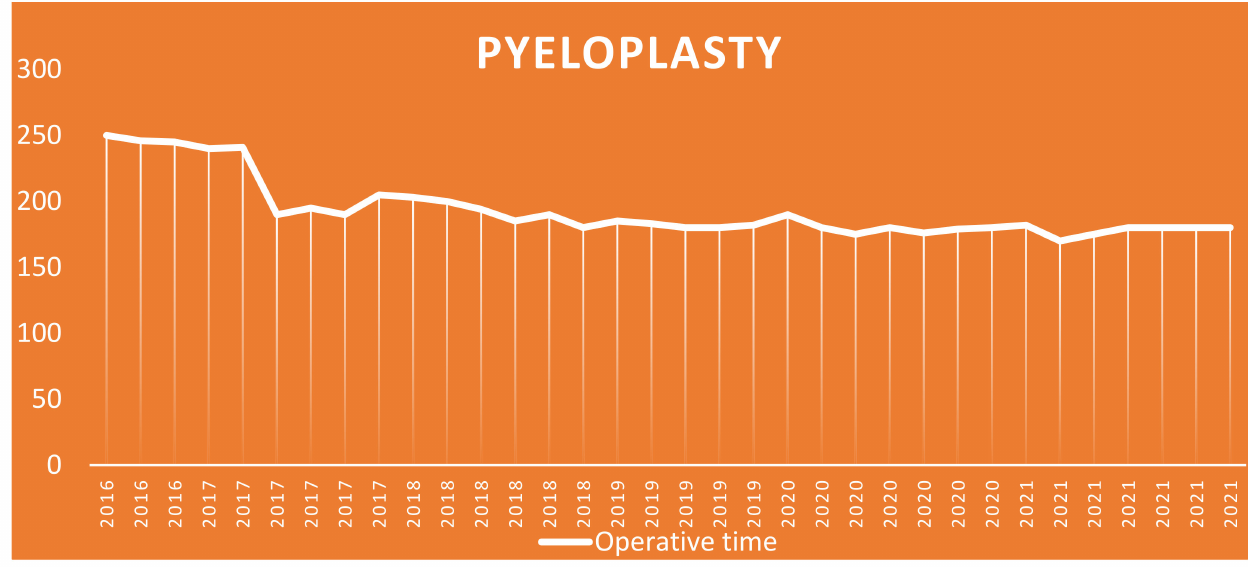
Figure 9. Pyeloplasty: trend of operating times over the